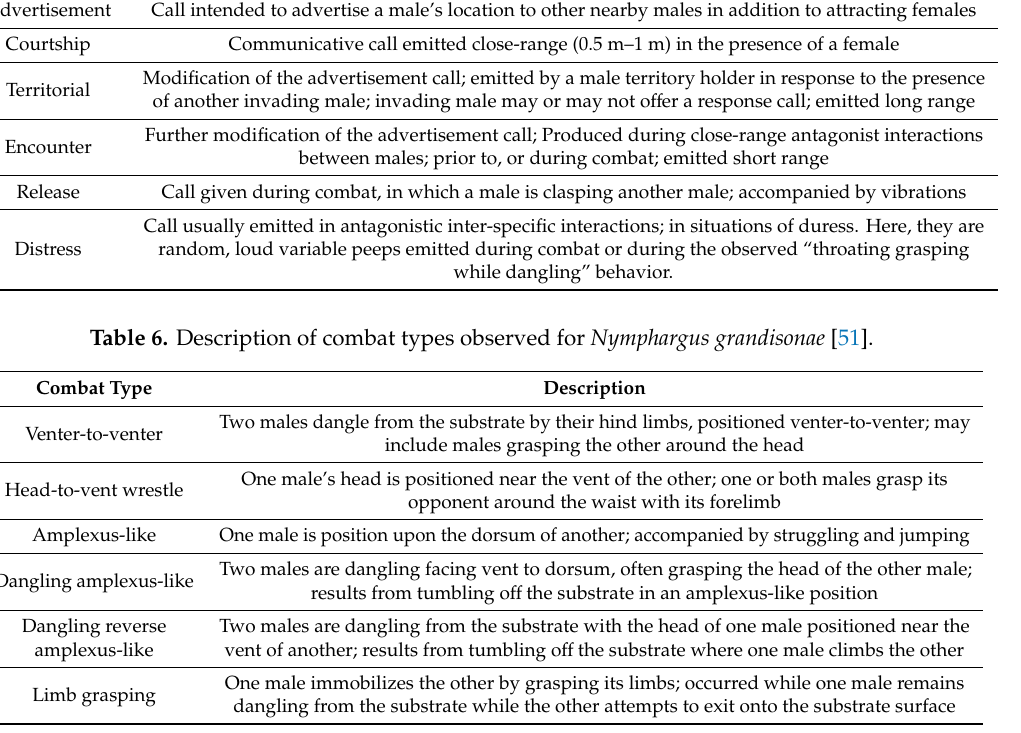
Table 7. Comparisons of call types recorded for Nymphargus grandisonae . Data are the mean ± standard deviation, followed by the range (modified from Hutter et al.